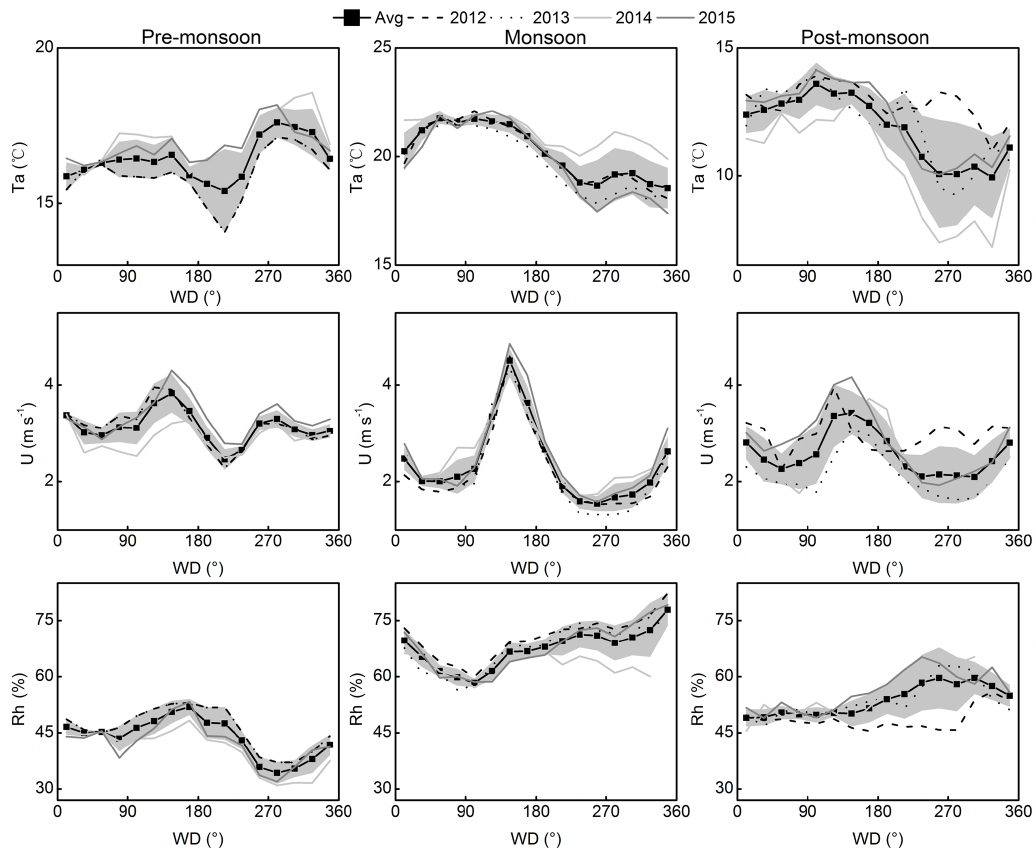
Figure 5. The bin-averaged wind speed ( U ), air temperature ( T a ) and relative humidity (RH) along with wind direction (WD) during pre- monsoon, monsoon and post-monsoon periods from 2012 to 2015. Every 22.5 ◦ was bin